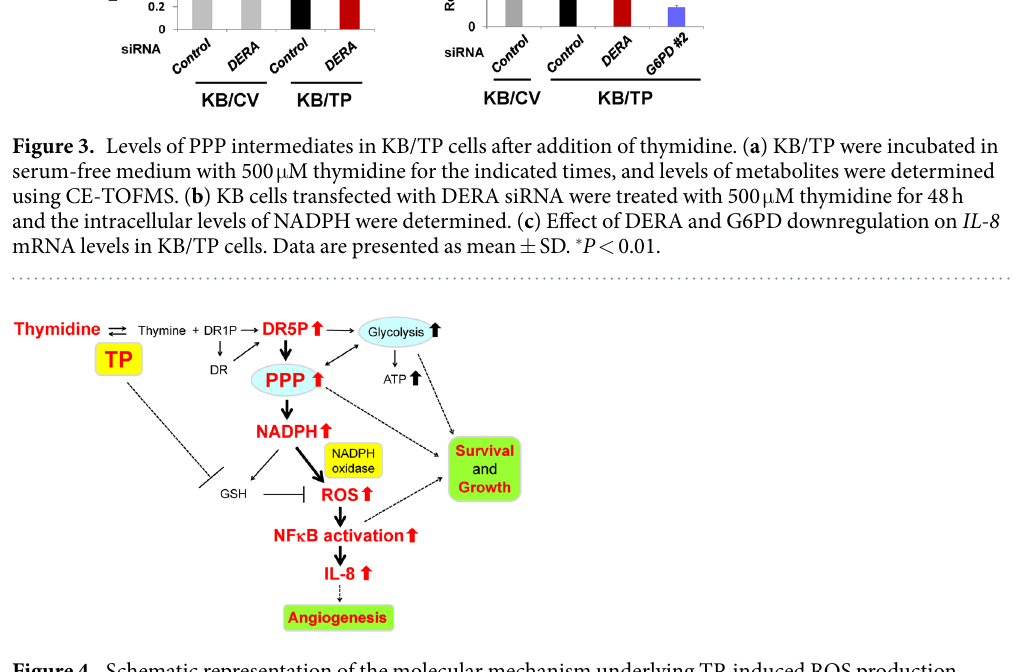
Figure 4. Schematic representation of the molecular mechanism underlying TP-induced ROS